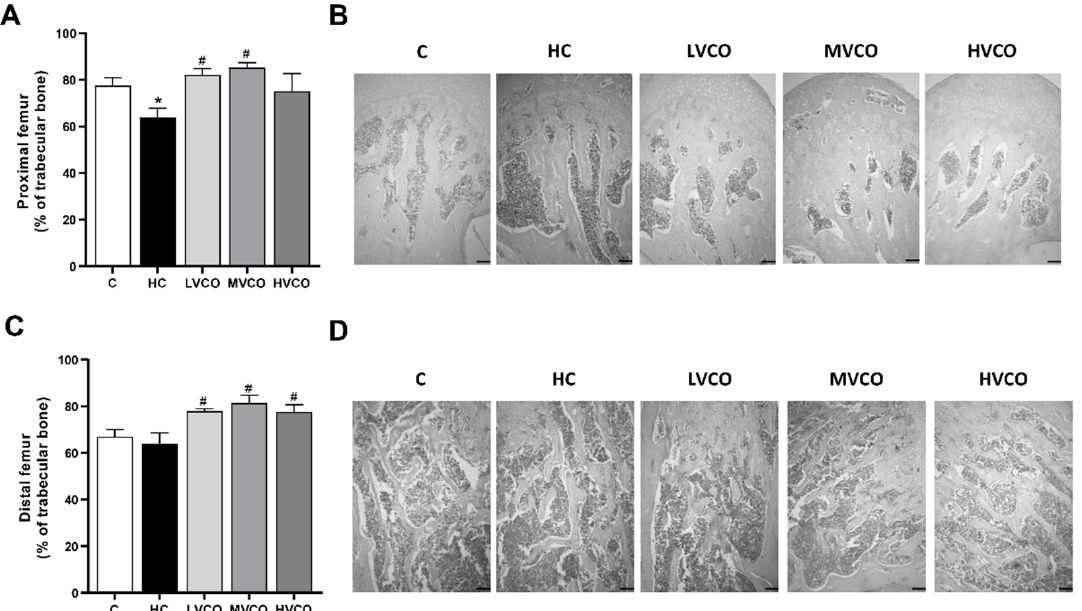
Figure 1. Effect of the HC diet and VCO supplementation on the percentage of trabecular bone in the proximal and distal femur. ( A ) The trabecular bone area and ( B ) histological sections of the proximal femur (scale bars represent 100 µm). ( C ) The trabecular bone area and ( D ) histological sections of the distal femur (scale bars represent 100 µm). Analyses were performed in mice fed a chow diet, high refined carbohydrate-containing (HC) diet, and HC diet supplemented with 1000 mg/kg (LVCO), 3000 mg/kg (MVCO), or 9000 mg/kg (HVCO) of body weight of virgin coconut oil (VCO). Values are means ± SEM ( n = 8). * compared with the control (C) group ( p < 0.05); # compared with HC group ( p <